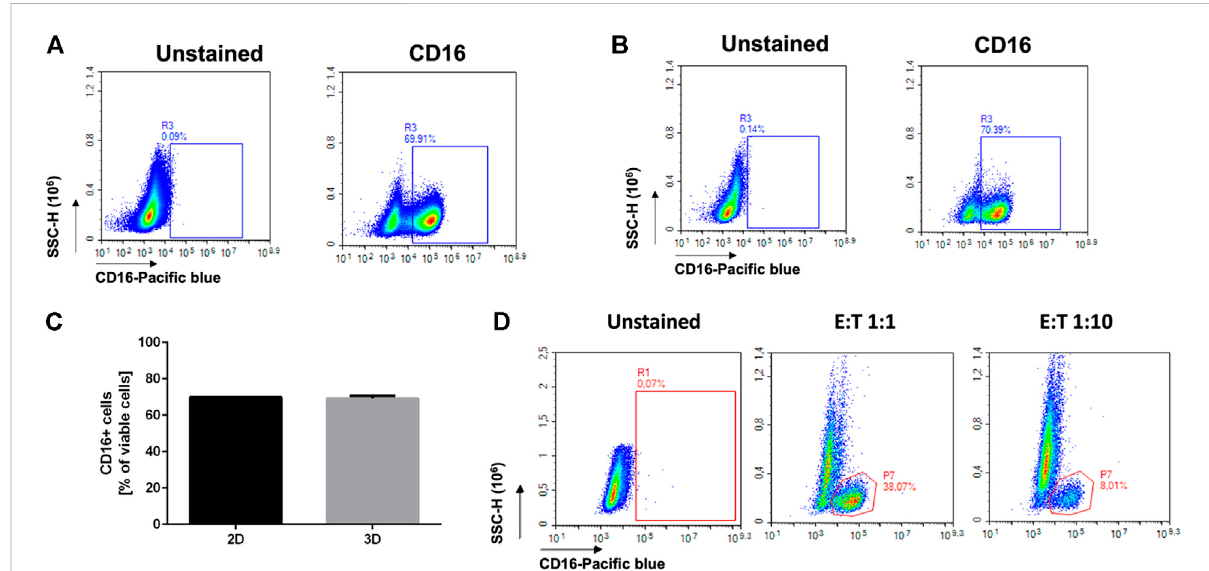
FIGURE 2 Reliability of fl ow cytometry analysis after cell recovery. NK cells were cultured in the standard 2D setting (A) , in 3D alginate embedding (B) , or co-cultured withtumor cellsinthe3Dalginatematrix (C) .The cellswerethenrecoveredandanalyzedfortheexpression oftheNKmarkerCD16. (A) CD16 expression on NK cells cultured in standard conditions (96-well plate, n = =6). (B) CD16 expression on NK cells cultured in a 3D alginate scaffold (n = =6). (C) No signi fi cant difference in CD16 expression is highlighted by fl ow cytometry in standard vs. 3D culture. (D)